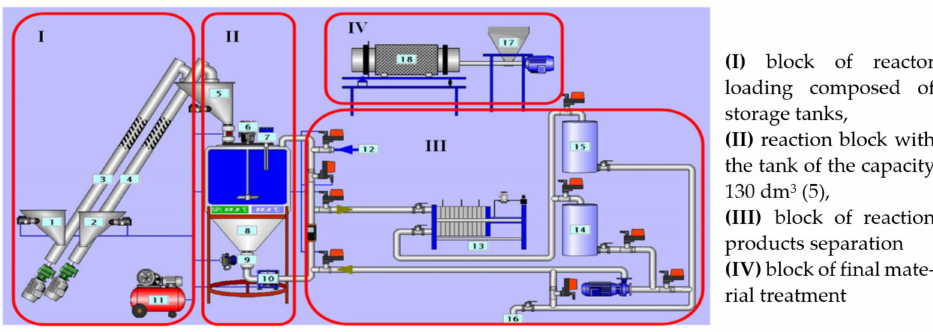
Figure 3. Production of zeolite NaP1.